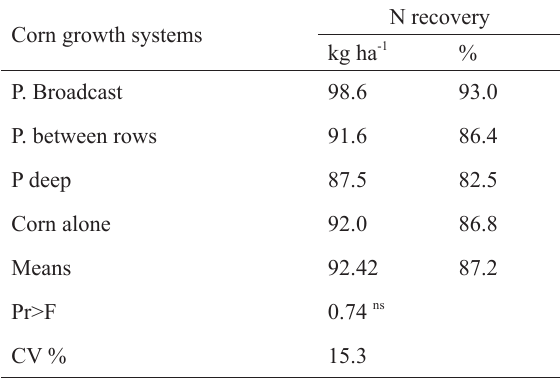
Balance of N fertilizer recovery at diff erent corn growth systems.